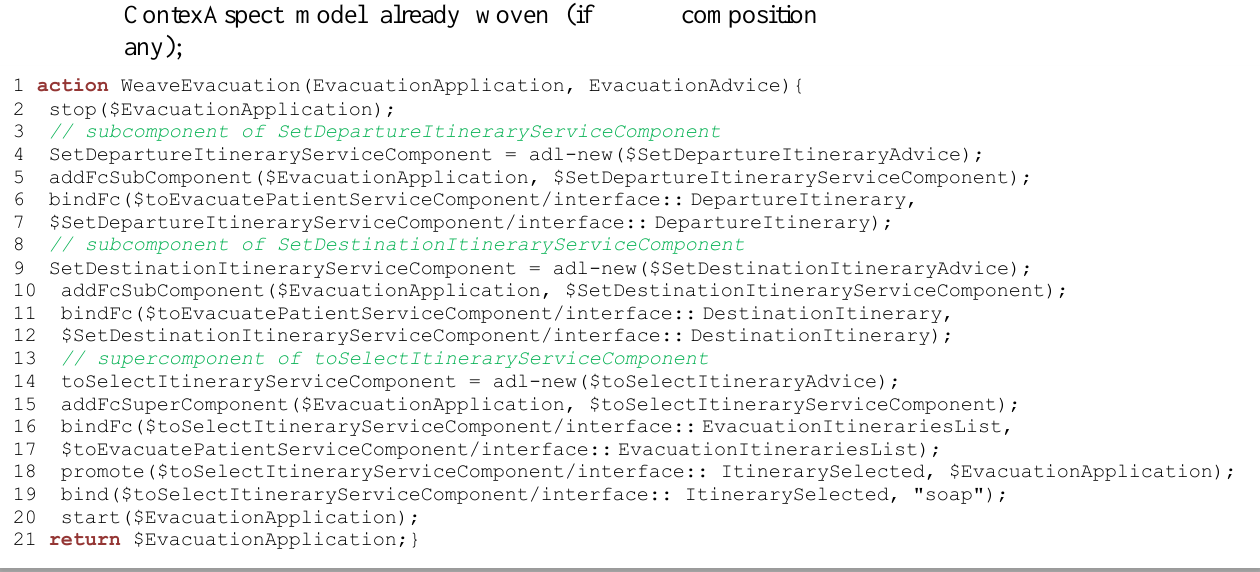
Figure 6 . Reconfiguration FScript code for Adapted Evacuation